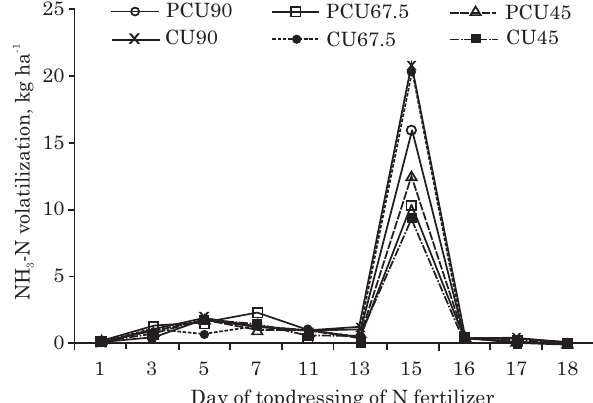
Figure 2. NH 3 -N volatilization losses, after application of conventional and polymer-coated urea. PCU 90-Polymer-coated urea (90 kg ha -1 N); PCU